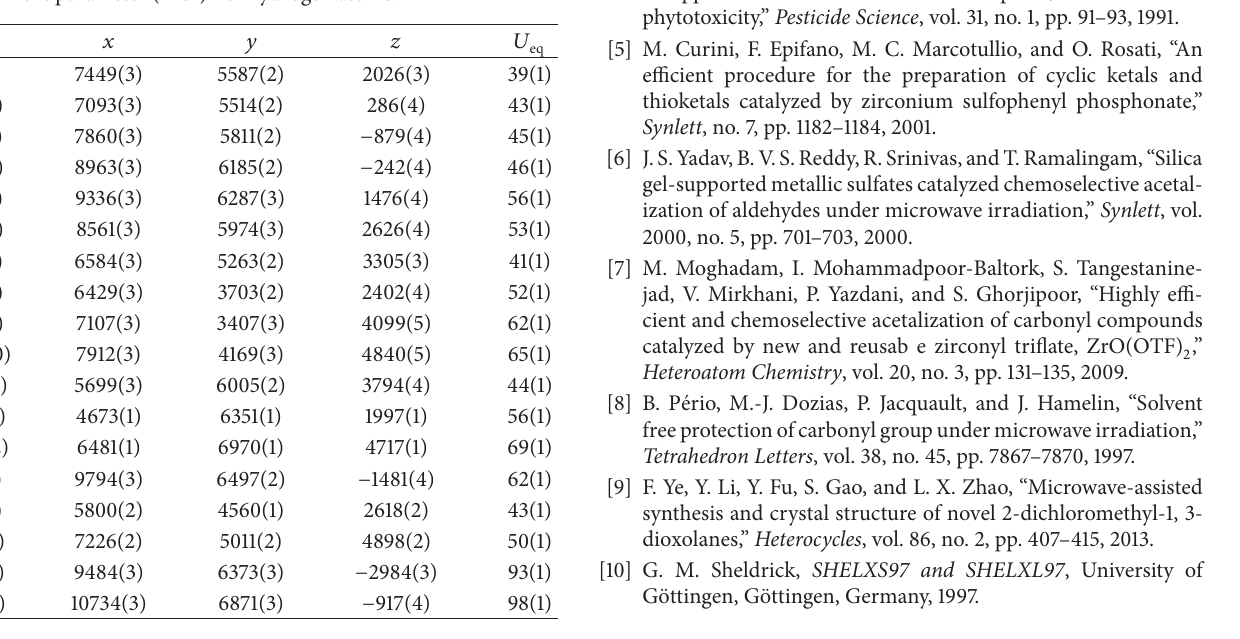
Table 3: Atomic coordinates ( × 10 4 ) and equivalent isotropic dis- placement parameter ( × 10 3 ) nonhydrogen